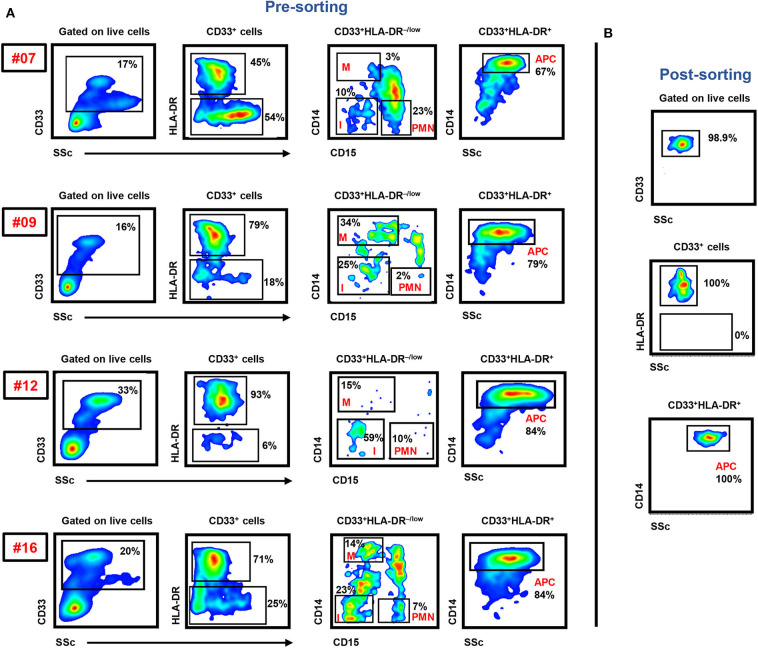
Gating strategy of I-MDSCs, M-MDSCs, PMN-MDSCs, and monocytic APCs. Peripheral blood mononuclear cells were isolated from four CRC patients (7, 9, 12, and 16). Flow cytometric plots show the levels of I-MDSCs (denoted as I), M-MDSCs (denoted as M), and PMN-MDSCs (denoted as PMN) gated on CD33+HLA-DR−/low and monocytic APCs gated on CD33+HLA-DR+ cells. Sorted pure myeloid cell subsets were used for RNA-Seq (A). Representative flow cytometric plots show the sorting purity of CD33+HLA-DR+CD14+ monocytic APCs (B).